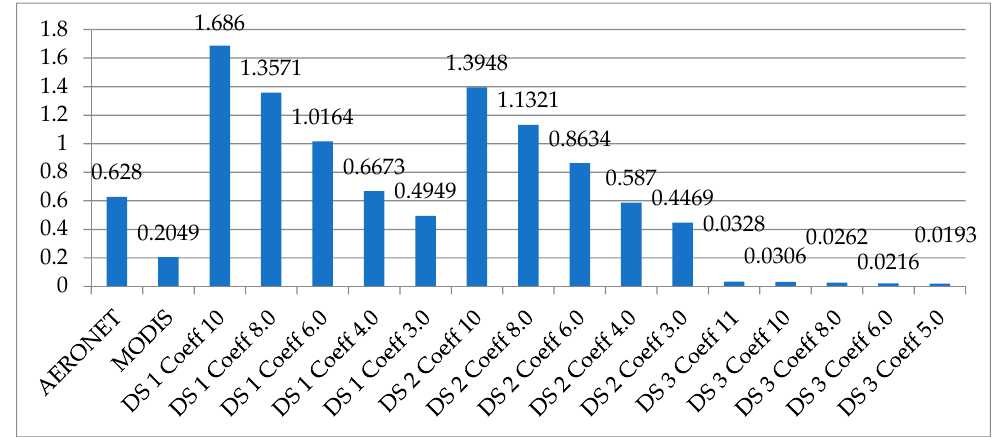
Figure 14. Average AOD over Cairo from MODIS, AERONET and the WRF-Chem model with all different dust schemes and tuning coefficient. from during dust event of 31 March 2013.